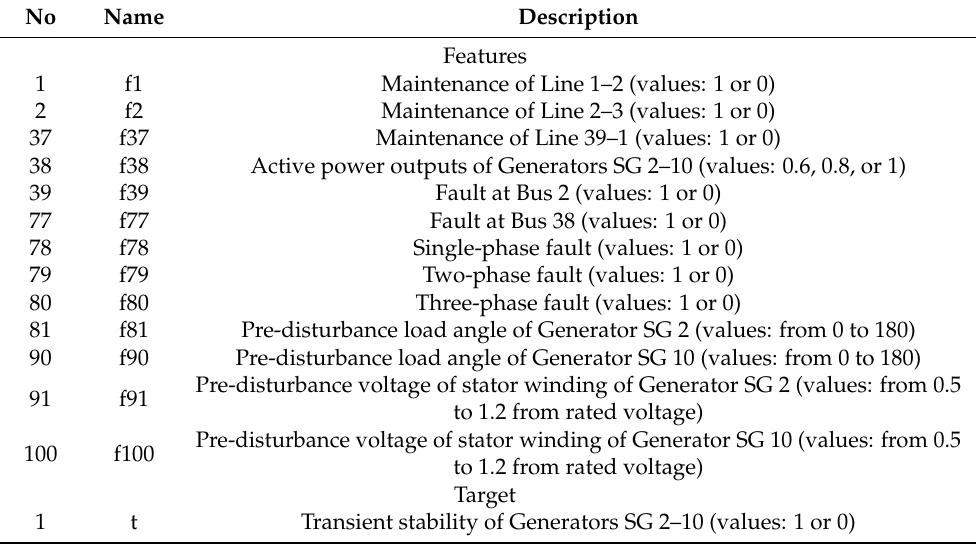
Table 2. Structure of the obtained data